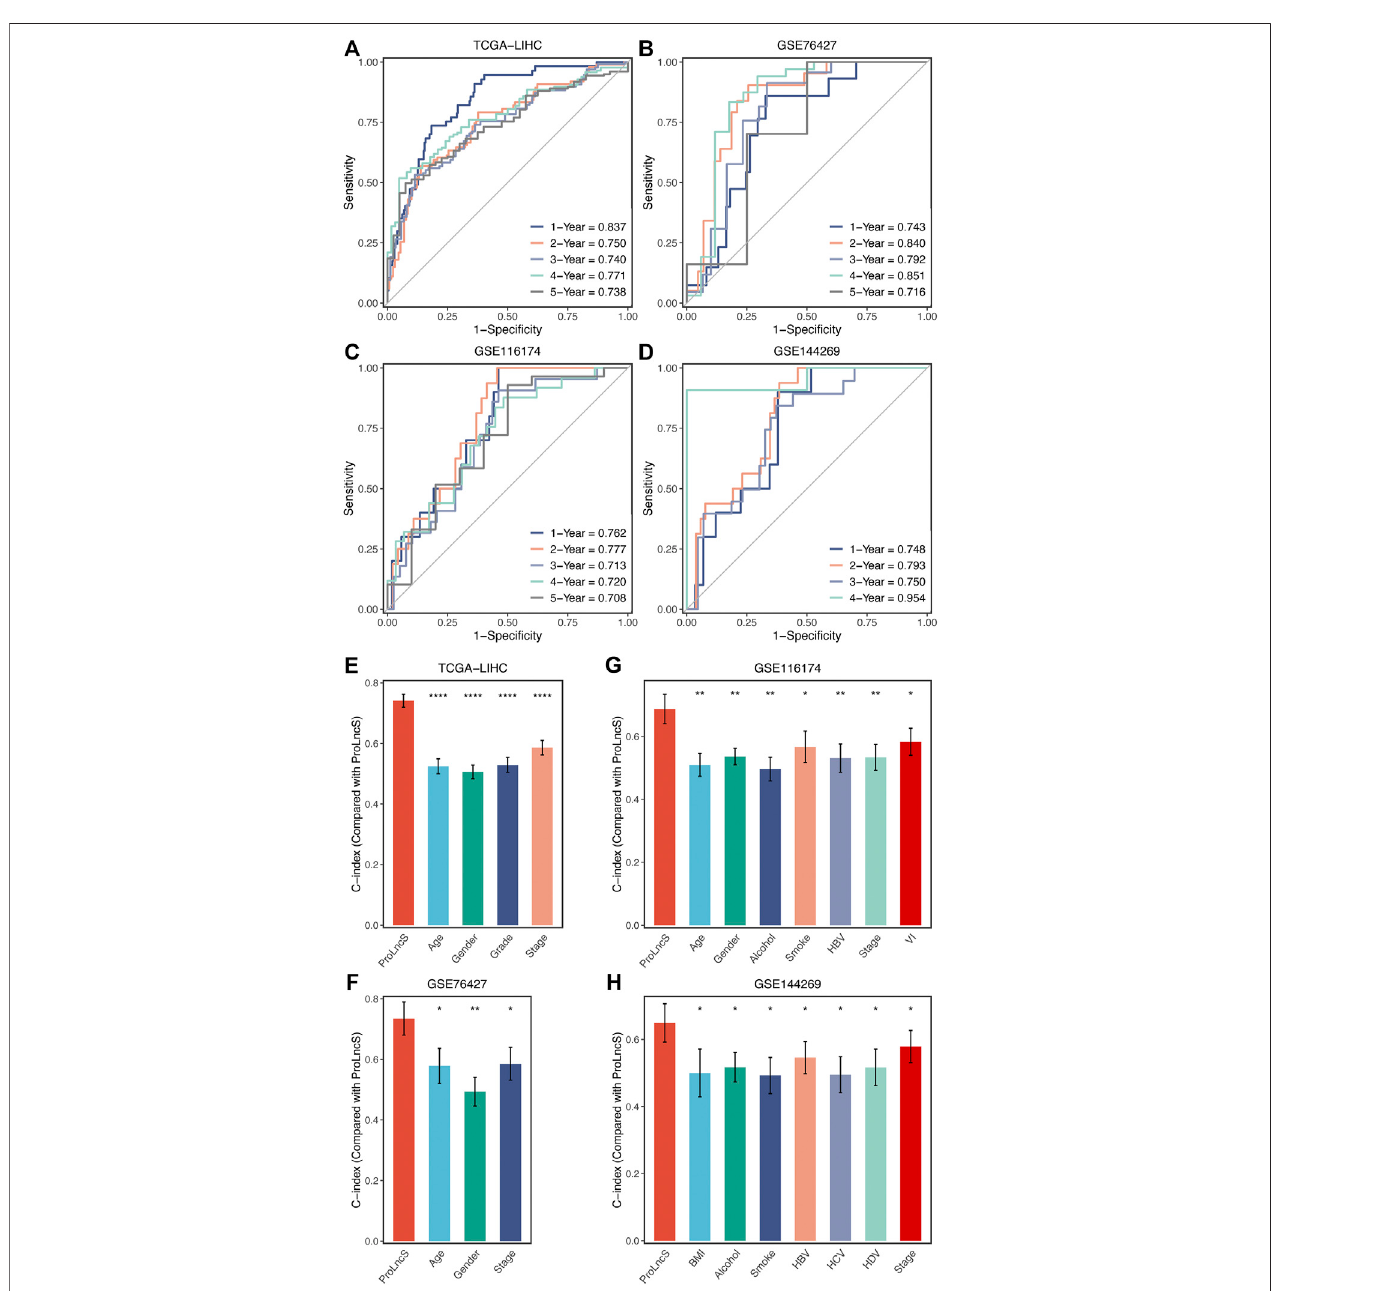
FIGURE 8 | Evaluation and comparison of ProLncS. (A – D) Time-dependent ROC analysis for predicting OS at 1 – 5 years in the TCGA-LIHC (A) , GSE76427 (B) , GSE116174 (C) , and GSE144269 (D) . The ability of ProLncS to predict prognosis of HCC was compared with common clinical variables in the TCGA-LIHC (E) , GSE76427 (F) , GSE116174 (G) , and GSE144269 (H) . * p < 0.05, ** p < 0.01, **** p < 0.0001.